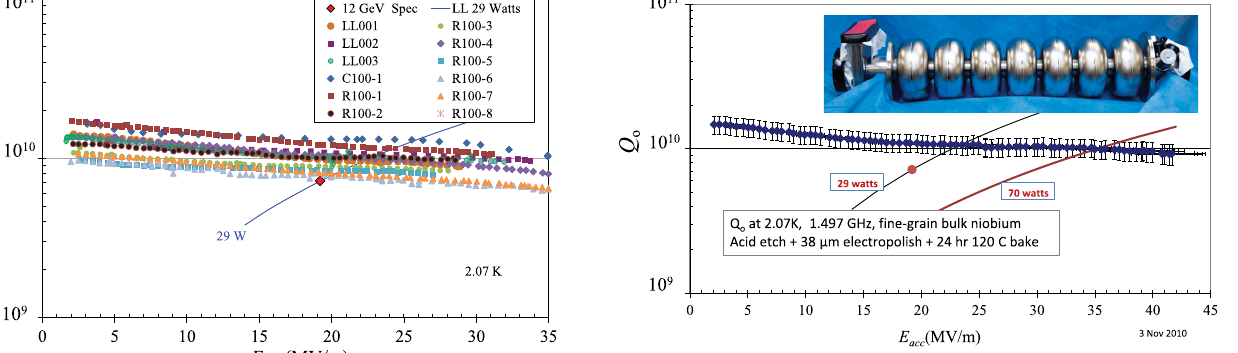
FIG. 27. Performance of CEBAF seven-cell cavities after ∼ 30 μ m EP (from [146]).